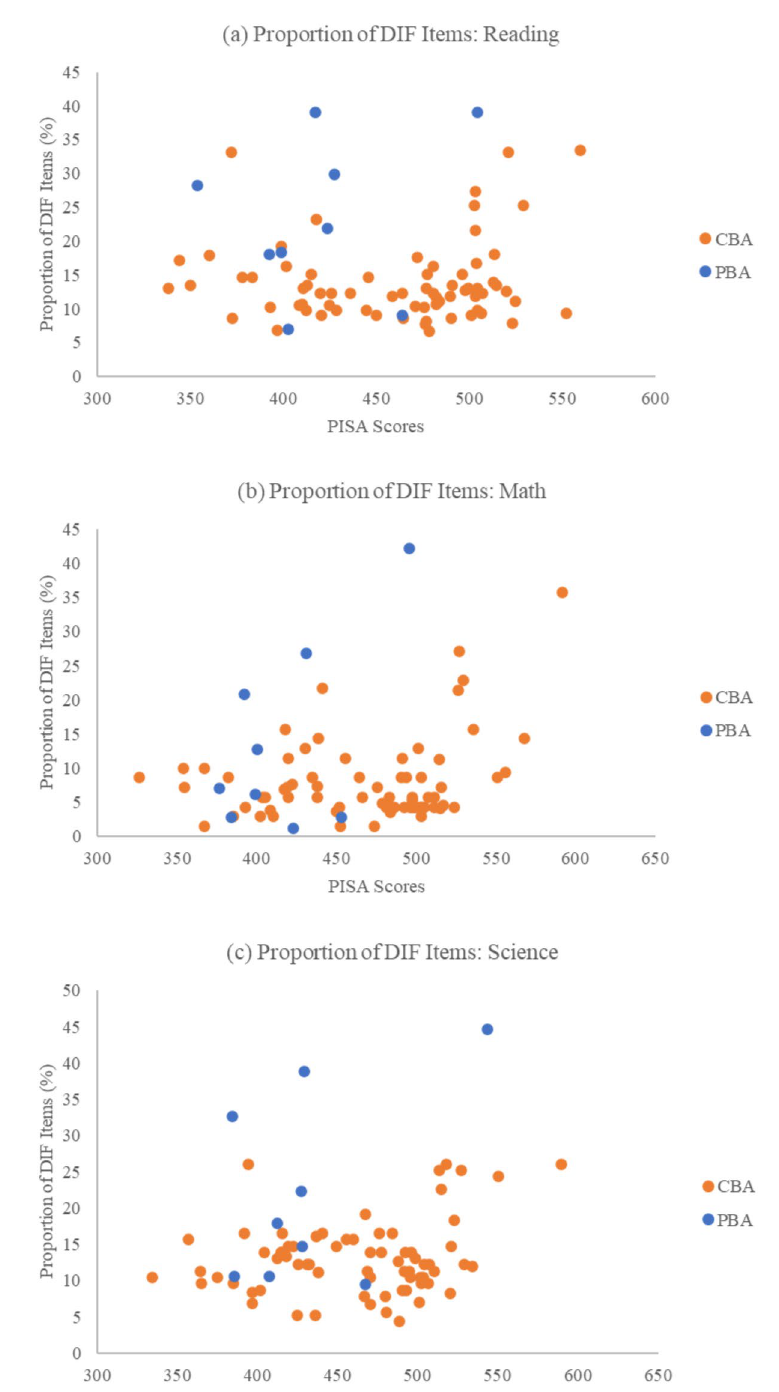
Fig. 1 The proportion of DIF items for CBA and PBA countries across PISA